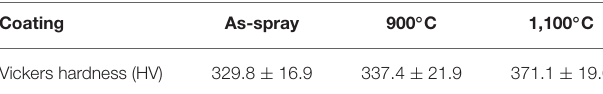
TABLE 2 | Vickers hardness of NiCrAlY coating.